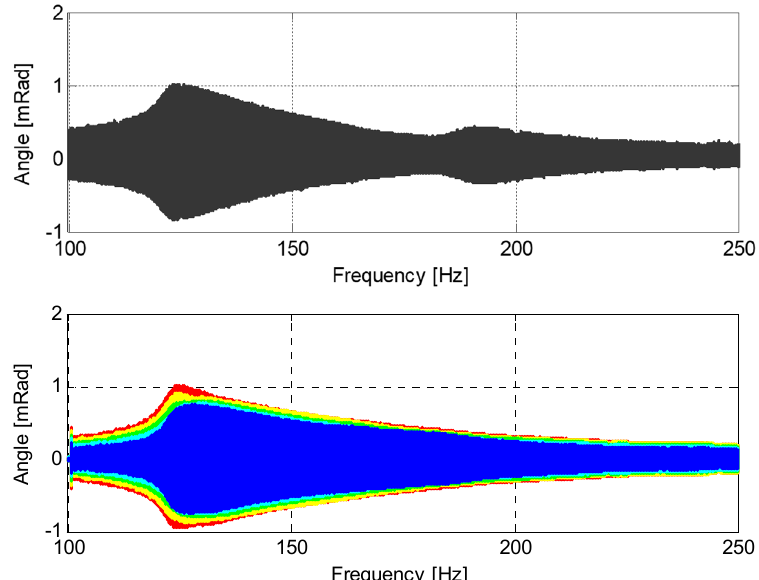
Figure 21. The results of RC testing. Standard RC test results are at the top; the results from the additional accelerometers are at the bottom. Material: saclSi 1; Isotropic pressure 50 kPa; Frequency spectrum 100–250 Hz; Excitation (torque) amplitude 4 V (– original built-in sensor, – the top sensor, S1, – the second sensor from the top, S2, – the third sensor from the top, S3, – the fourth sensor from the top, S4, – the bottom sensor, S5).